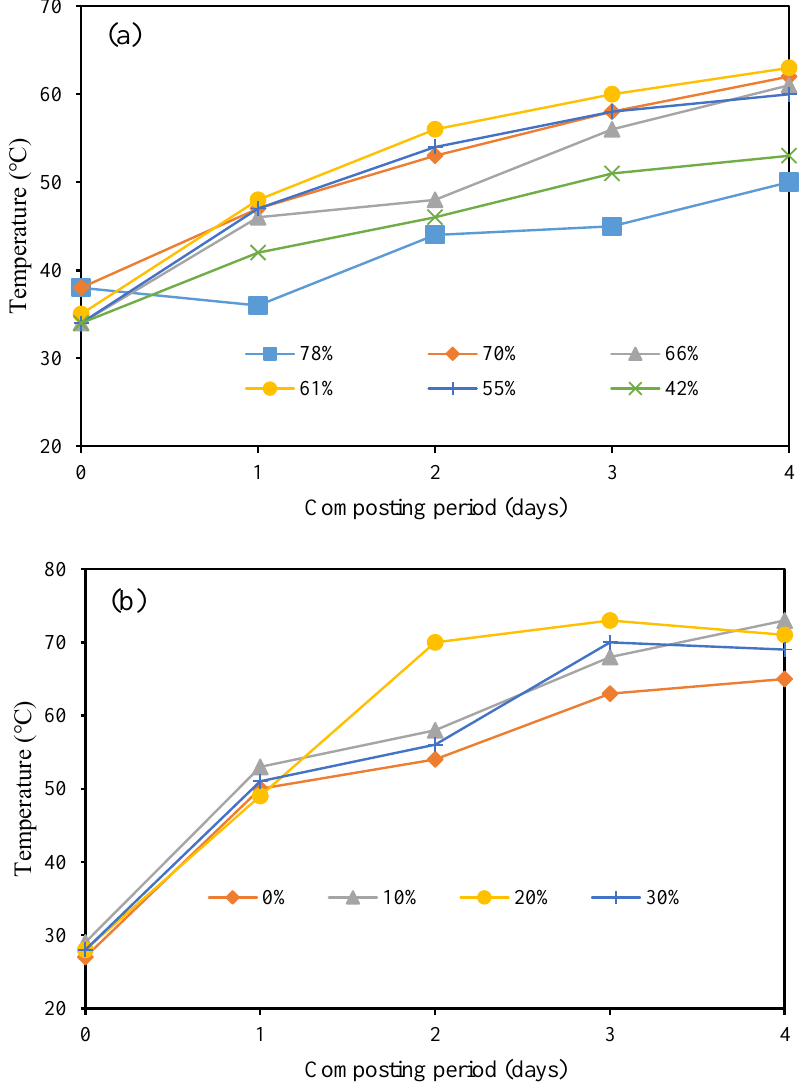
Figure 1. Temperature development influenced by ( a ) initial moisture content and ( b ) seeding